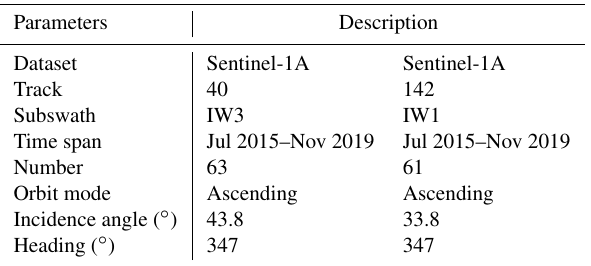
Table 1. Metadata about the Sentinel-1 data used in the study.